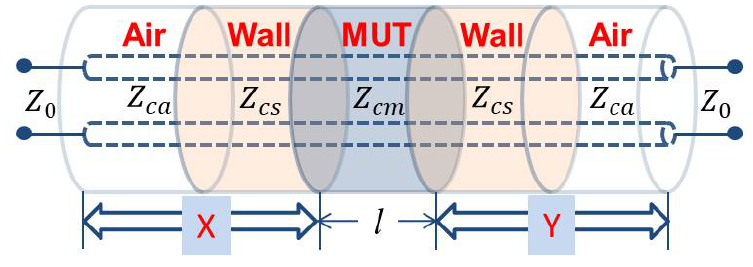
Figure 1. A transmission-line-based sensing device, with the material under test being contained in a microfluidic channel formed by SU-8 polymer